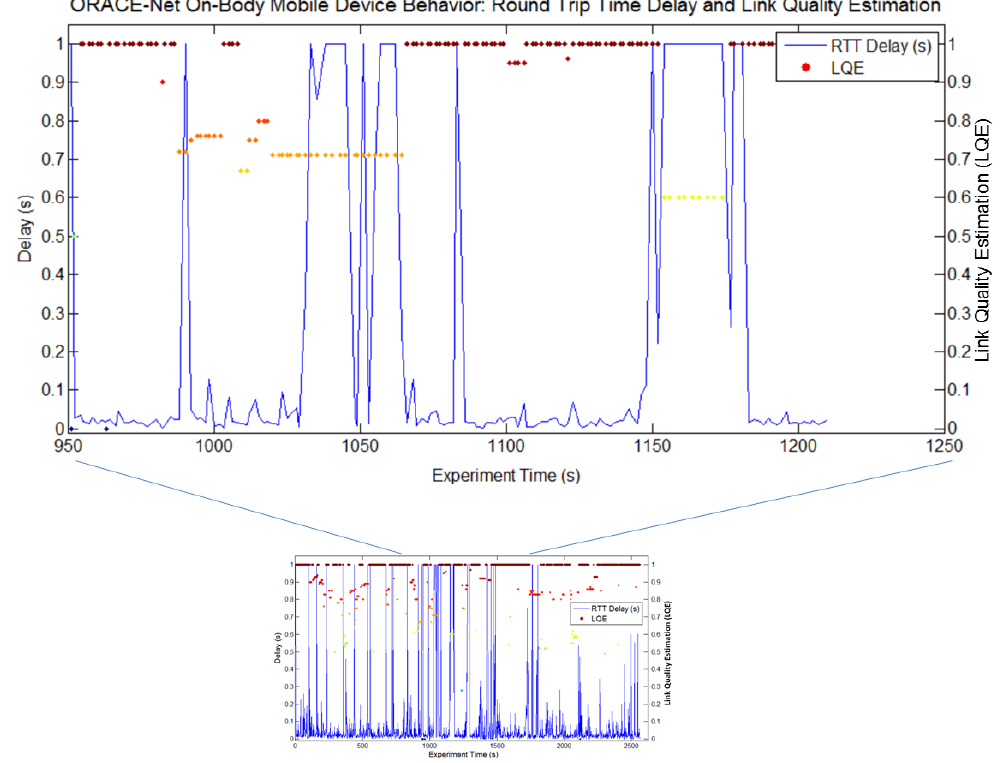
Figure 8. ORACE-Net on-body mobile device behavior: round trip time delay and link quality